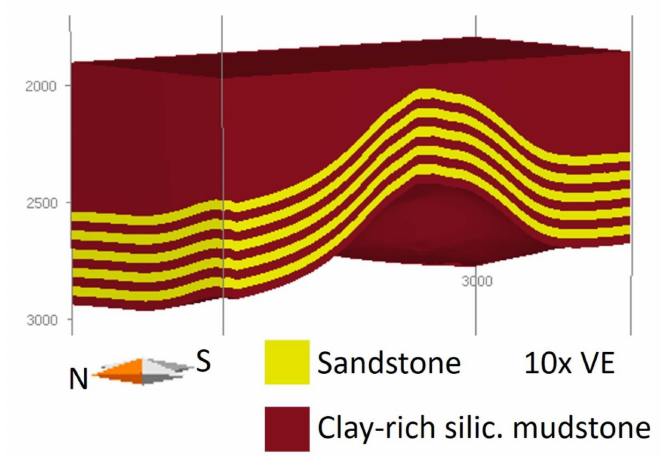
Figure 1. Stratigraphy of our 3-D model (interbedded mudstone and clays within the anticlinal dome feature, draped by a thick layer of clay-rich mudstone). Note 10 × vertical exaggeration.